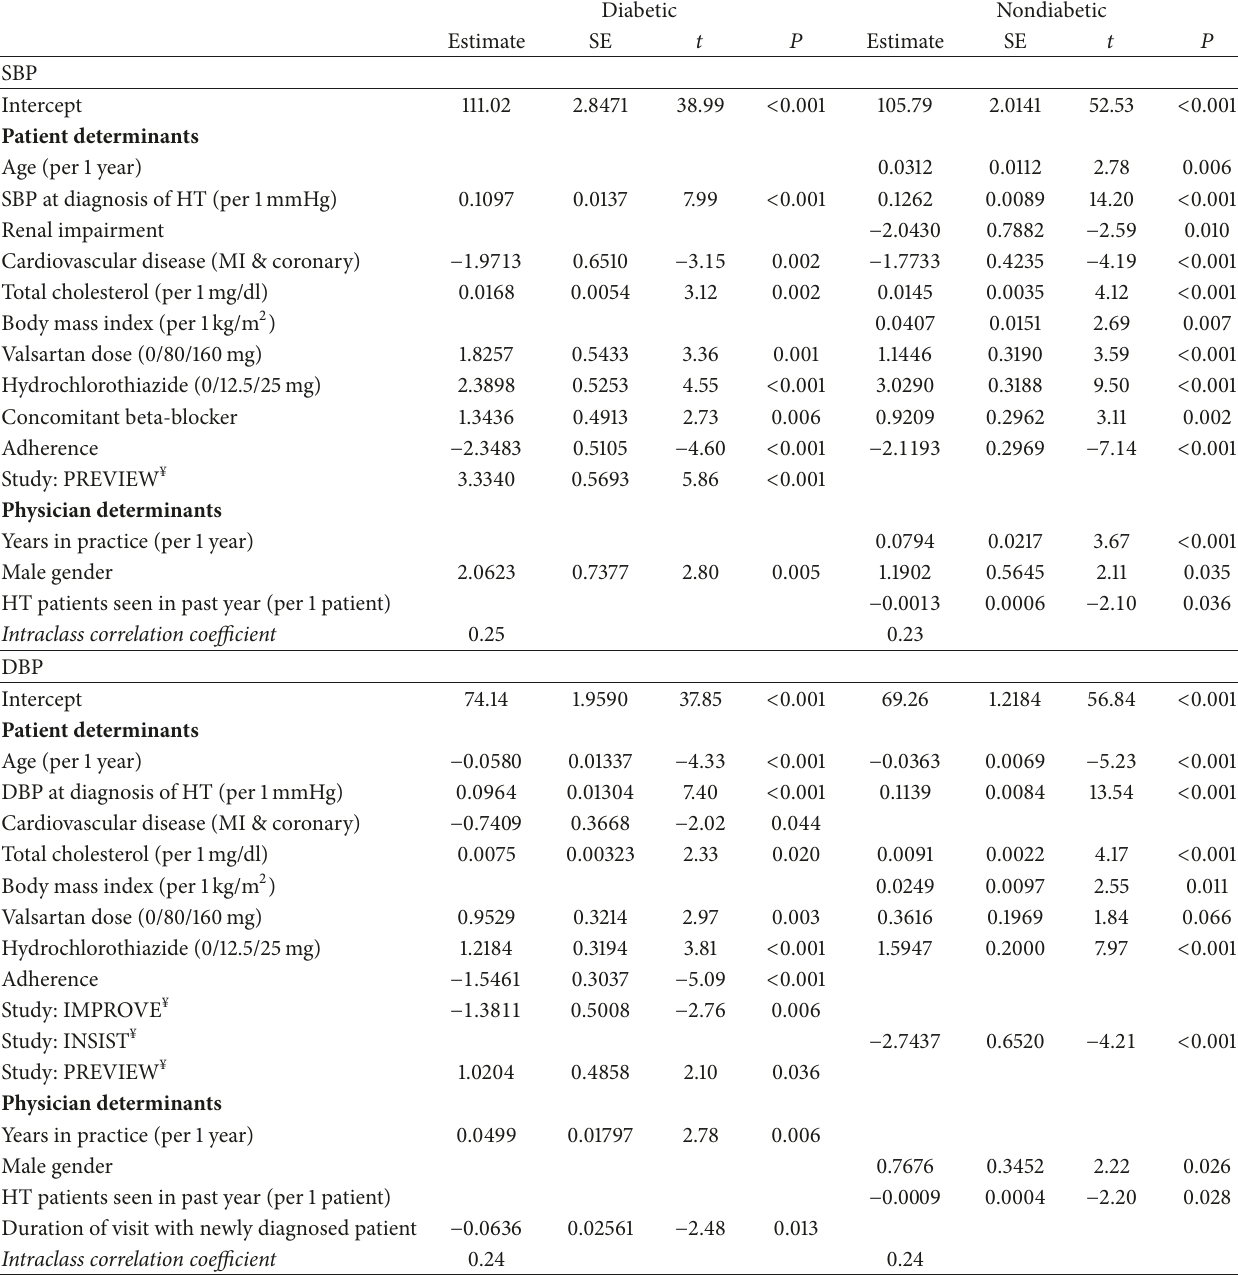
Table 4: Hierarchical linear modeling of SBP and DBP at 90 days by diabetes